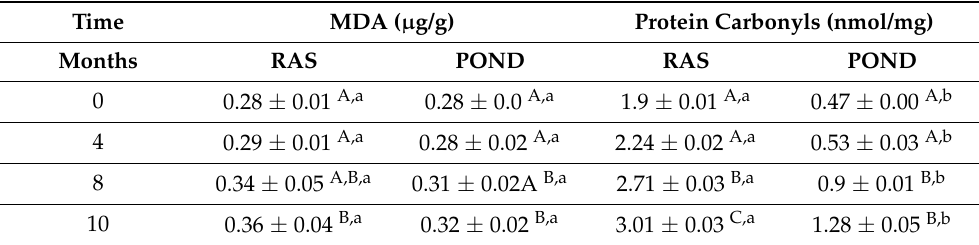
Table 6. MDA ( µ g/g) and carbonyl content (nmol/mg) parameters in perch fillets from RAS and pond rearing systems during refrigerated storage at +4 ◦ C (mean ± S.D., n = 6). Time MDA ( µ g/g) Protein Carbonyls (nmol/mg) Months RAS POND RAS